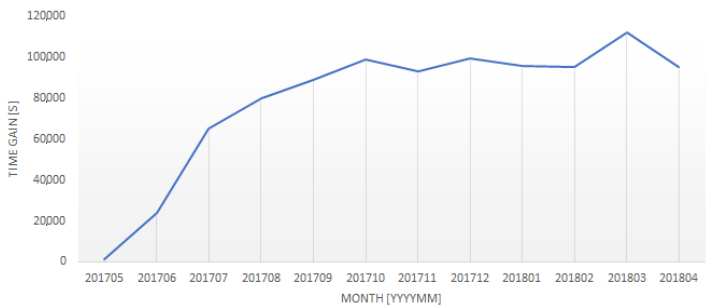
Figure 12. A simulated gain of the time per month, in seconds, for Risk max =